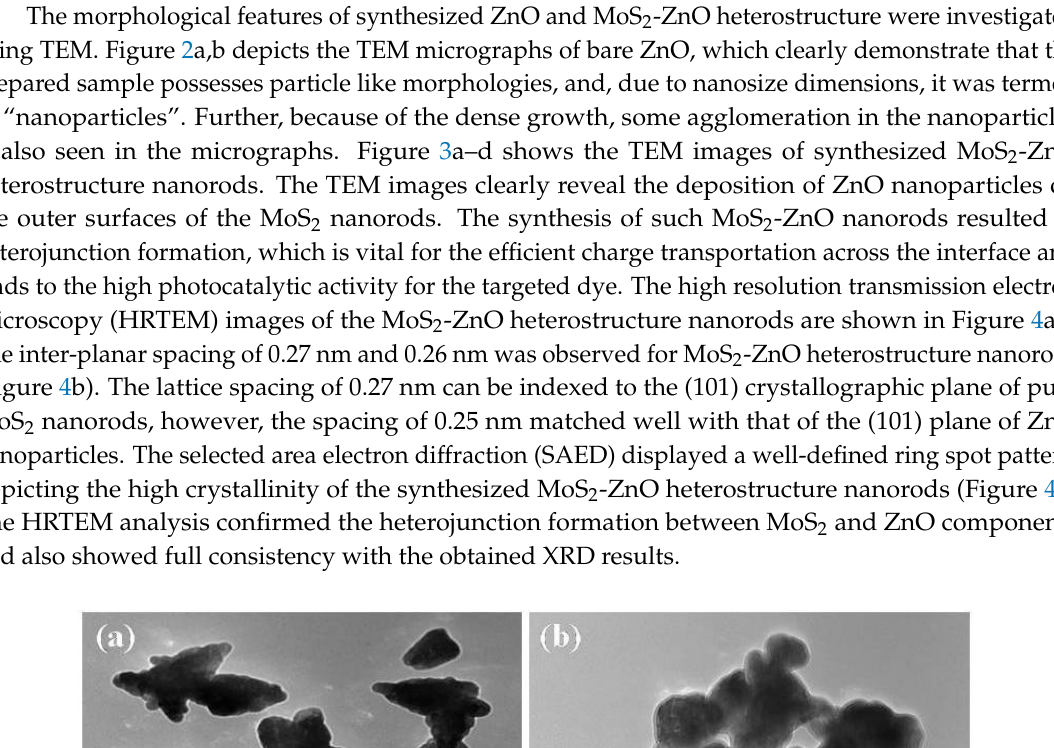
Figure 2. ( a , b ) Typical TEM images of pure ZnO nanoparticles.